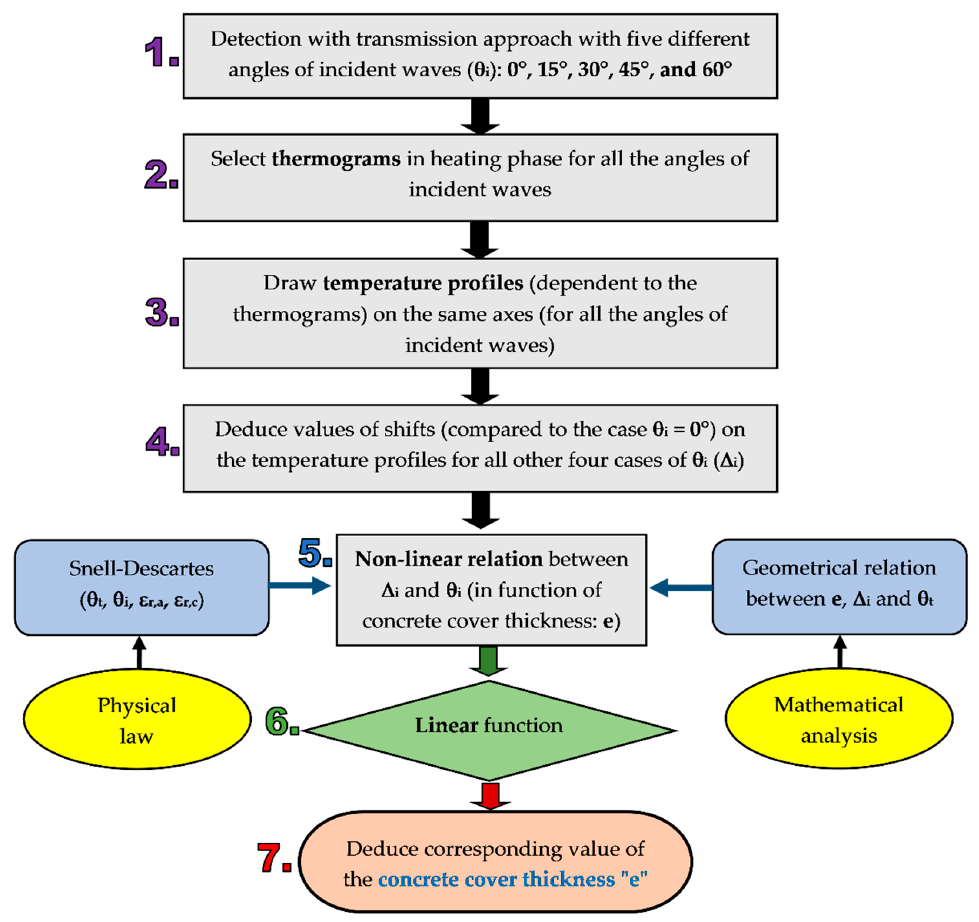
Appl. Sci. 2022 , 12 , 9865 Figure 1. Methodology for detecting the concrete cover thickness of one-layer reinforcements in RC wall by microwave thermography method with transmission approach.